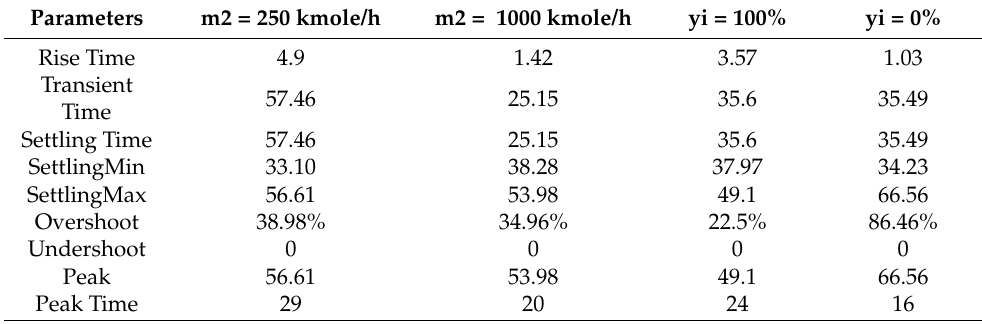
Table 2. Step-response characteristics for system in Figure 7.